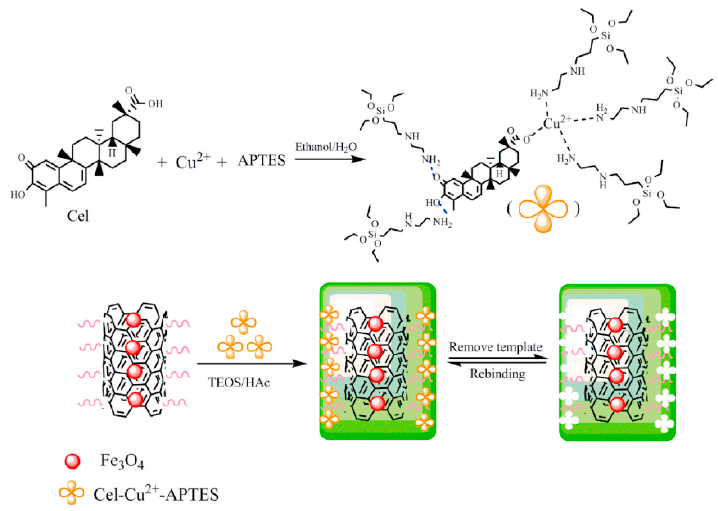
Figure 7. The synthesis procedure of Cel-MIPs@MCNTs [42].